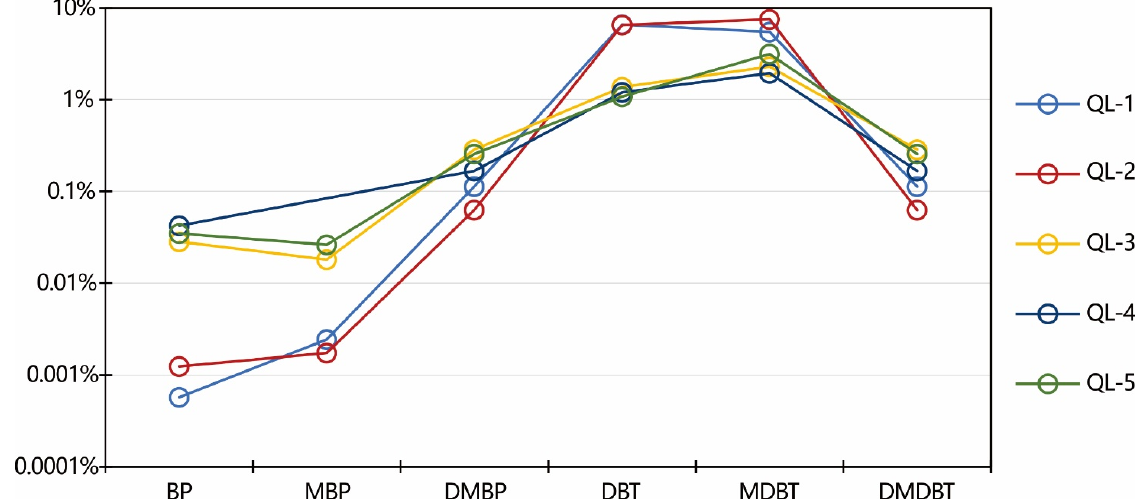
Figure 14. Relative percentage of the biphenyl series and dibenzothiophene series.